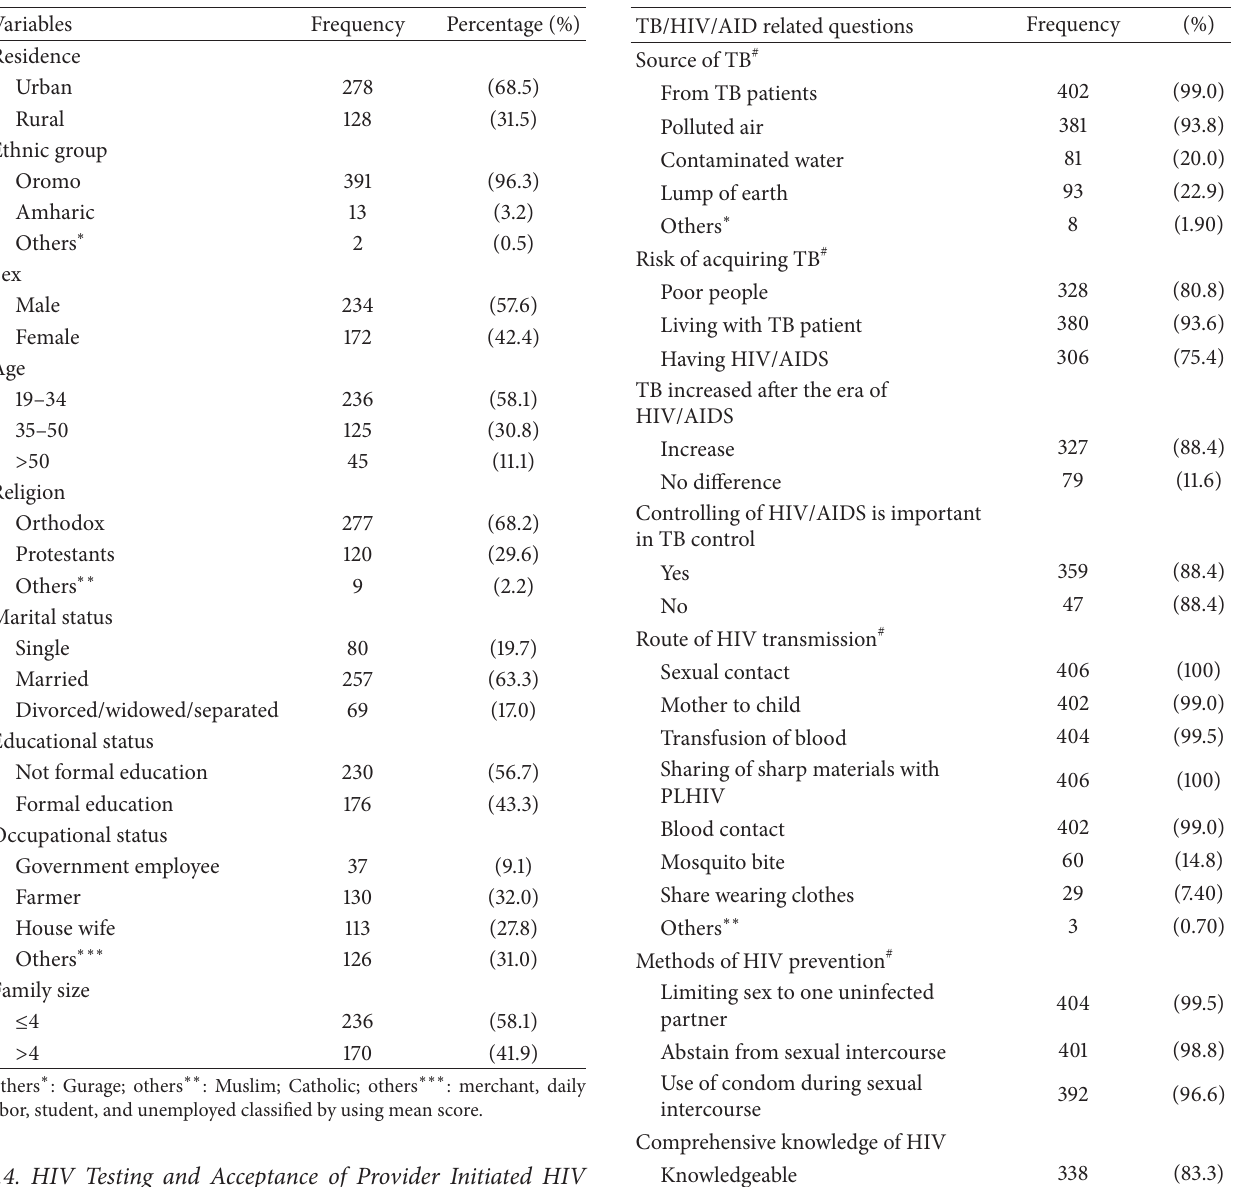
Table 1: Sociodemographic characteristics of tuberculosis patients in East Wollega administrative zone at selected health centers, Au- gust 2010 ( 𝑁 = 406 ).